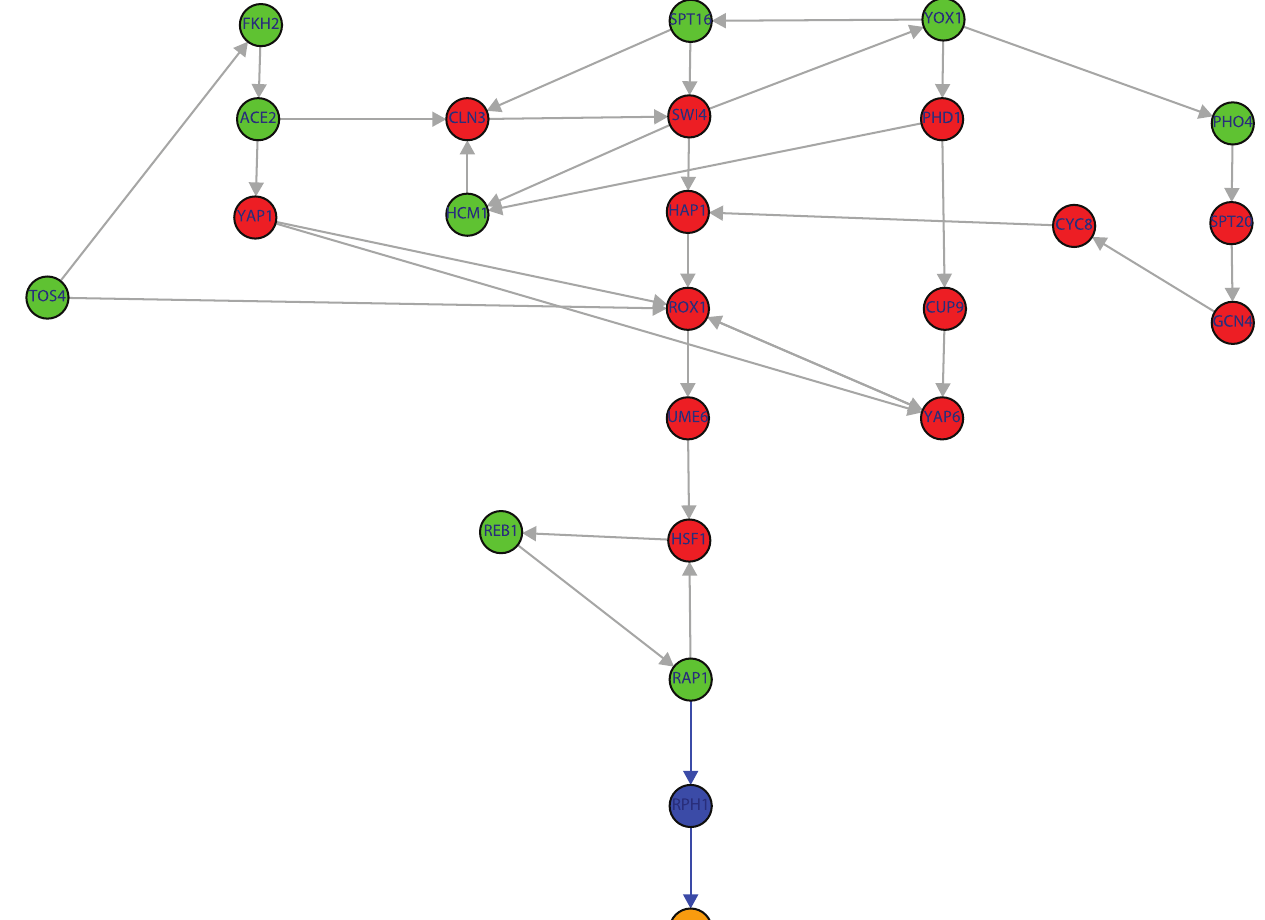
Figure 4. Subnetwork of the TRN consisting of 24 genes (color code as in Fig. 1). The shown subnetwork complements the results in table 1 by providing detailed information about the genes involved in the shortest paths. Blue edges indicate the shortest path connecting RAP1 R RPH1 R SPH1.